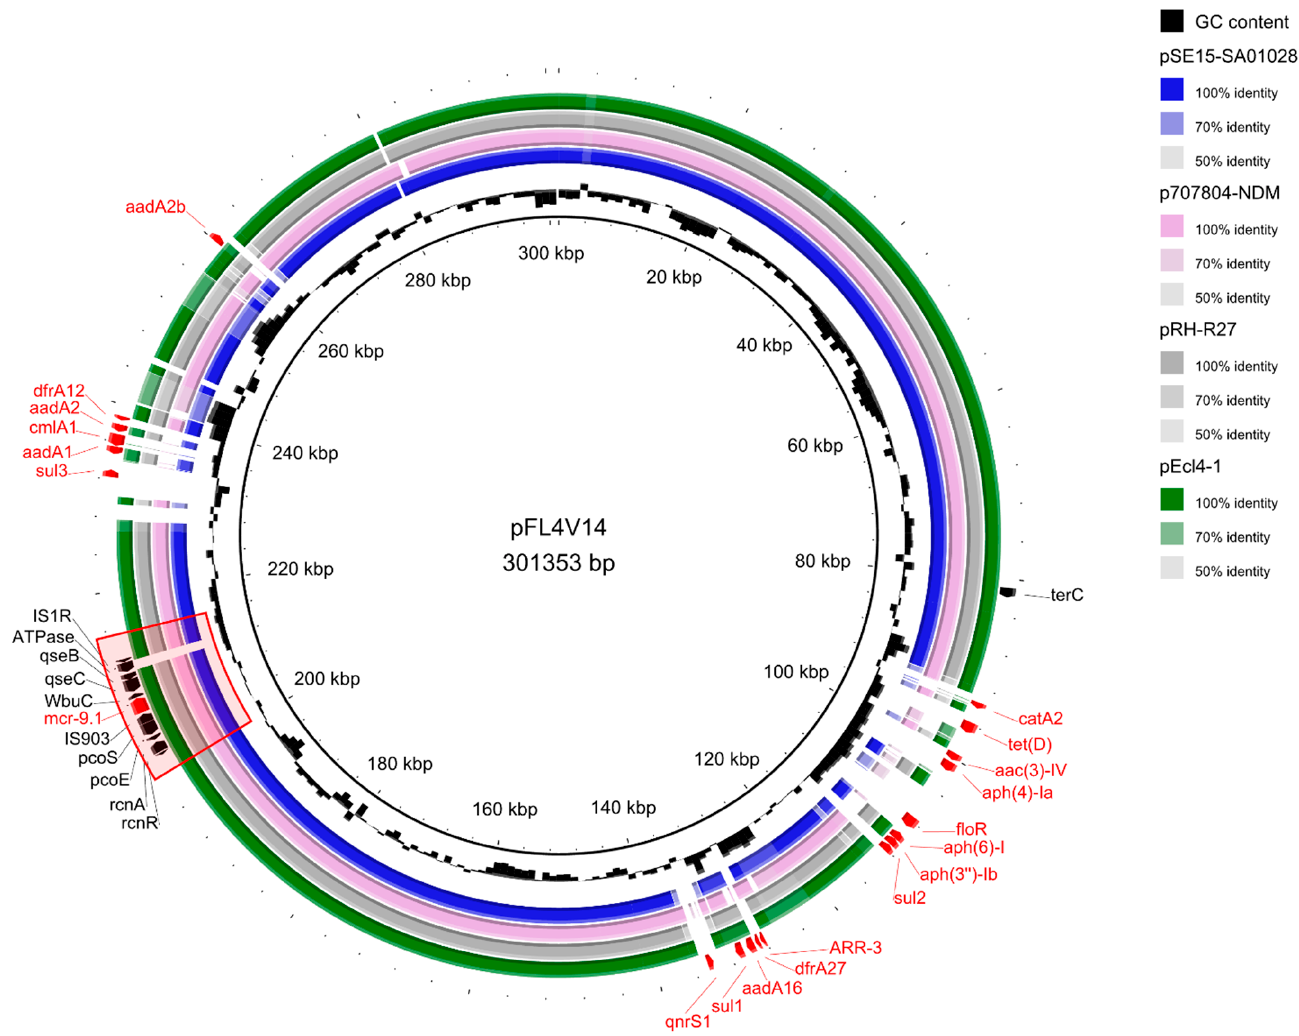
Figure 1. Circular map of IncHI2 plasmid pFL4V14 isolated from E.coli_MDRbs22 compared to the closest plasmids according to BLAST+ ([23], CP026661, LN555650, MH909331). Resistance genes and the mcr-9 cassette have been highlighted in red.